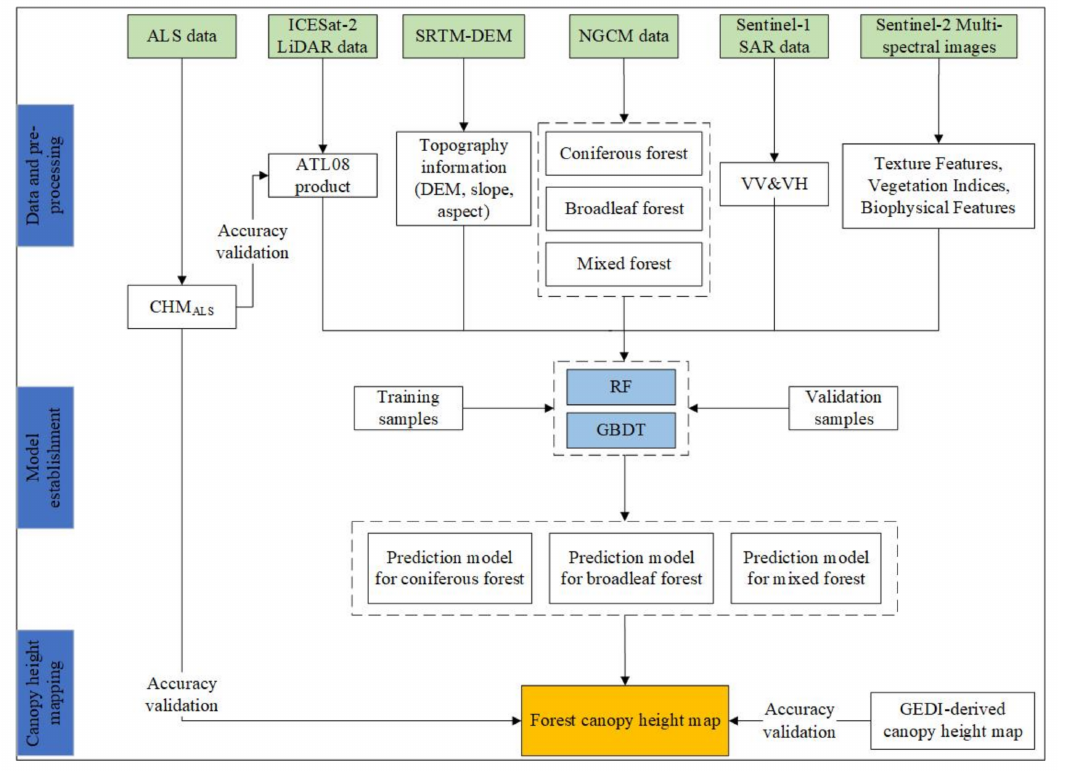
Figure 2. A flowchart of the proposed